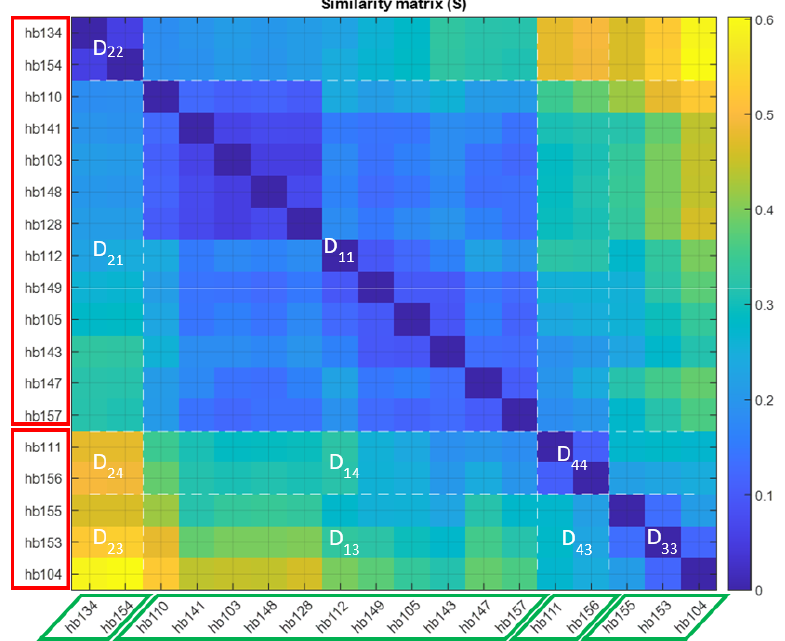
Figure 10. Similarity matrix ( S ) for the suburban environment at the weekend. White dashed lines separate the four clusters of the Q = 4 clustering solution (marked as green rhomboids at the bottom), which, in turn, also includes the Q = 2 solution (also marked on the left-side as red rectangles). Inter- ( i = j ) and intra-cluster ( i (cid:54) = j ) distances are highlighted in white and denoted as D ij